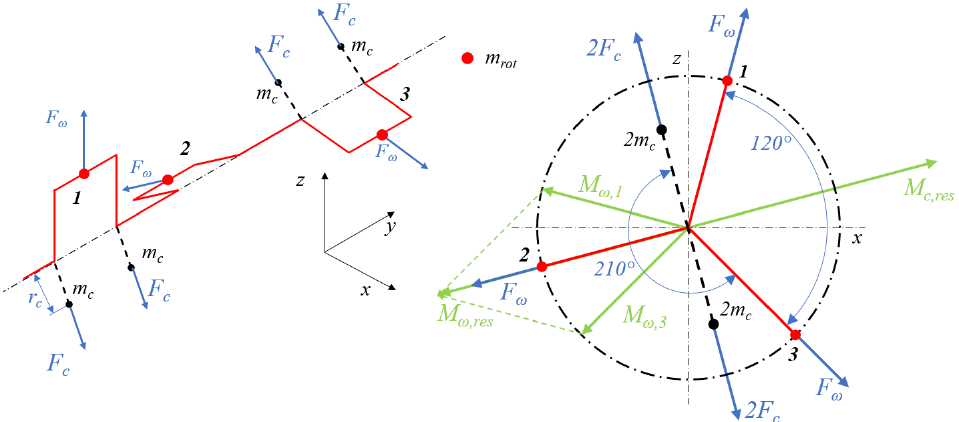
Figure 2. Isometry and relative polar plot of the crankshaft for a 3 cylinder in-line engine, including the centrifugal forces